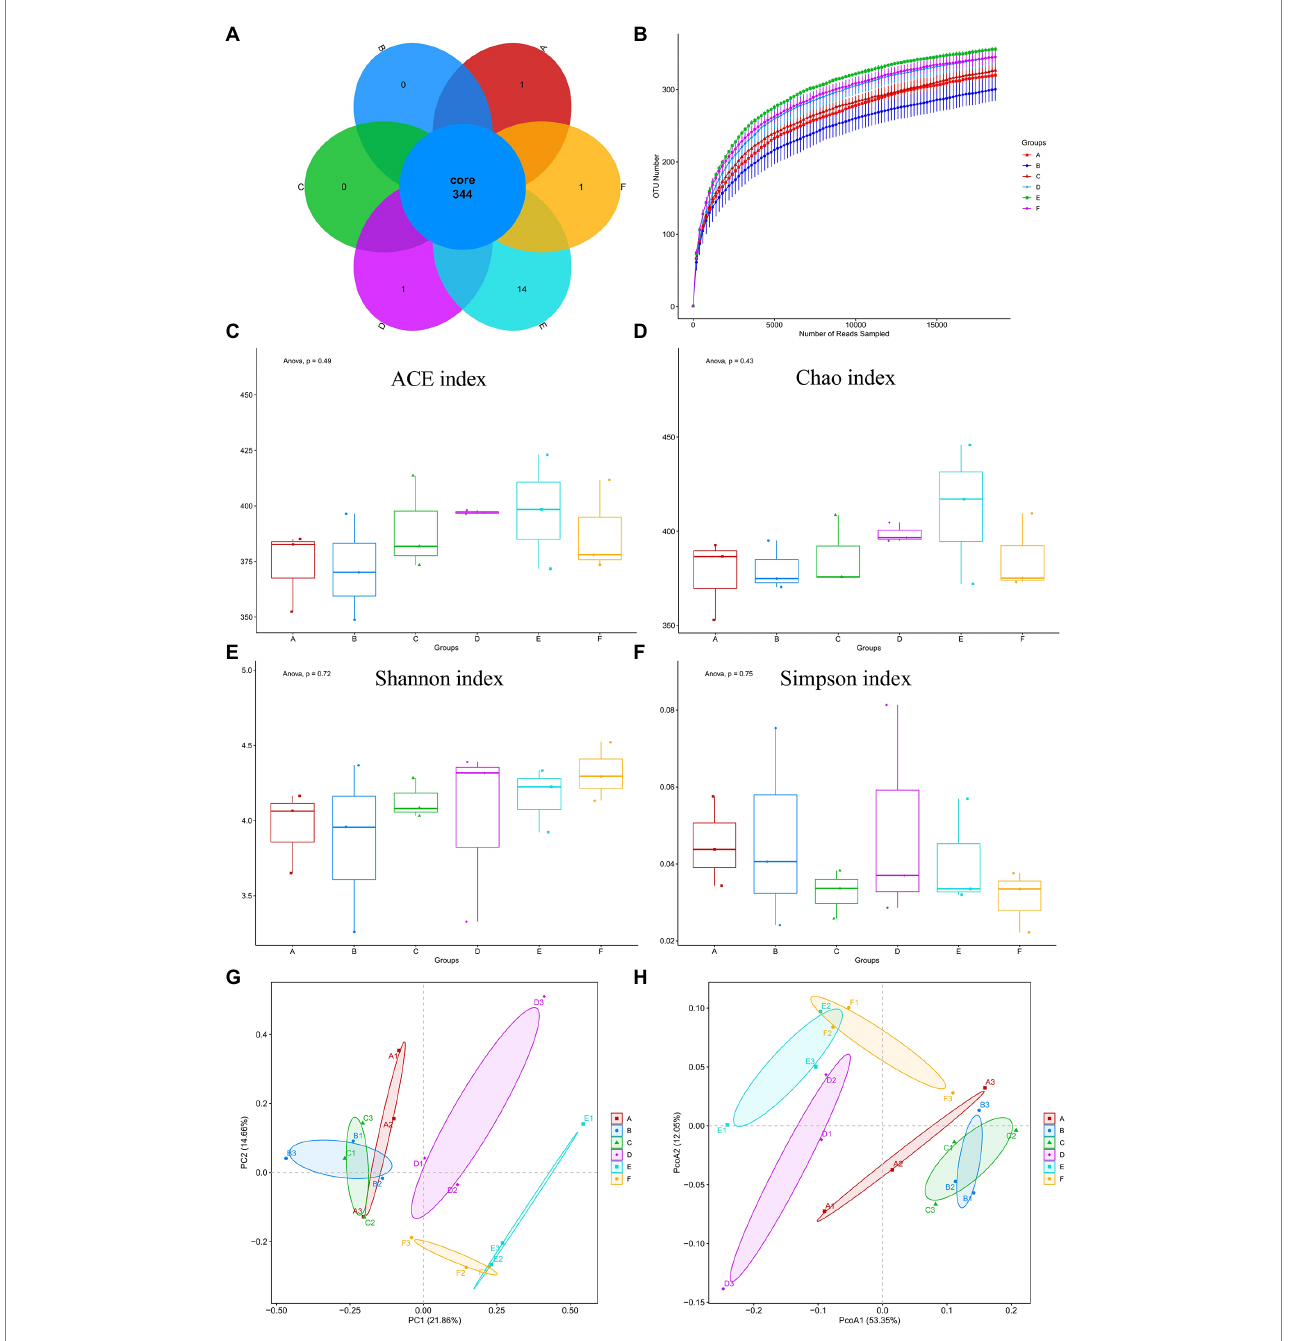
FIGURE 3 Number of bacterial OTUs and diversity index statistics in mice feces in six groups. (A) Venn diagram, where areas of overlap indicate the numbers of OTUs shared among the overlapping groups. (B) Alpha index spar curve, determine whether the amount of sequencing data is enough according to the curve flat. (C) ACE index. (D) Chao1 index. (E) Shannon index. (F) Simpson index. (G) PCA based on OTU level. (H) PCoA based on OTU level. Each point represents a sample and the distance between points is used to map the size of the difference in the structural composition of the gut flora between the two samples. In the picture, A represents Control group, B represents ETEC K88 group, C represents CYN. L group, D represents CYN. M group, E represents CYN. H group, and F represents BTW